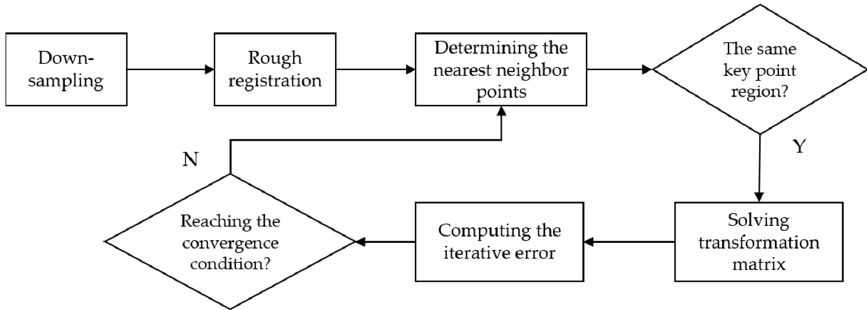
Figure 9. Flow chart of the frame-to-frame point cloud registration algorithm.